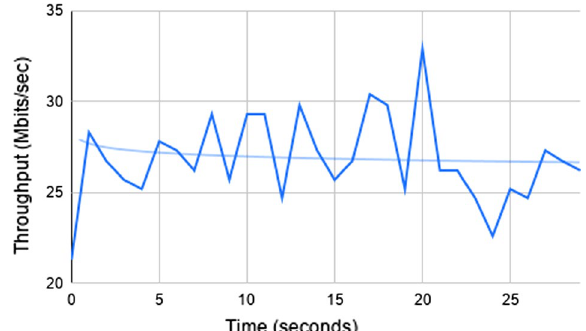
Fig. 9 iperf3 test results for throughput on the testbed for a 30 s window connecting between two edge